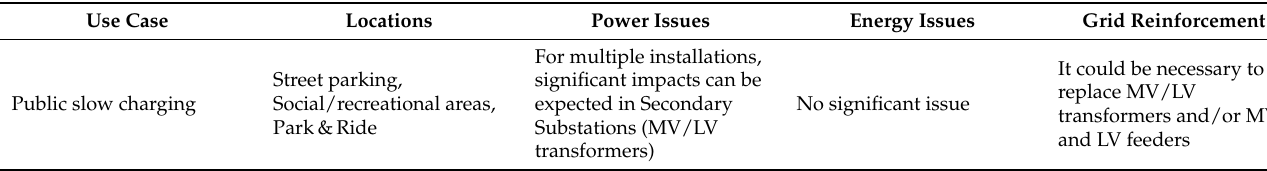
Table 5. Challenges of EV integration to grid